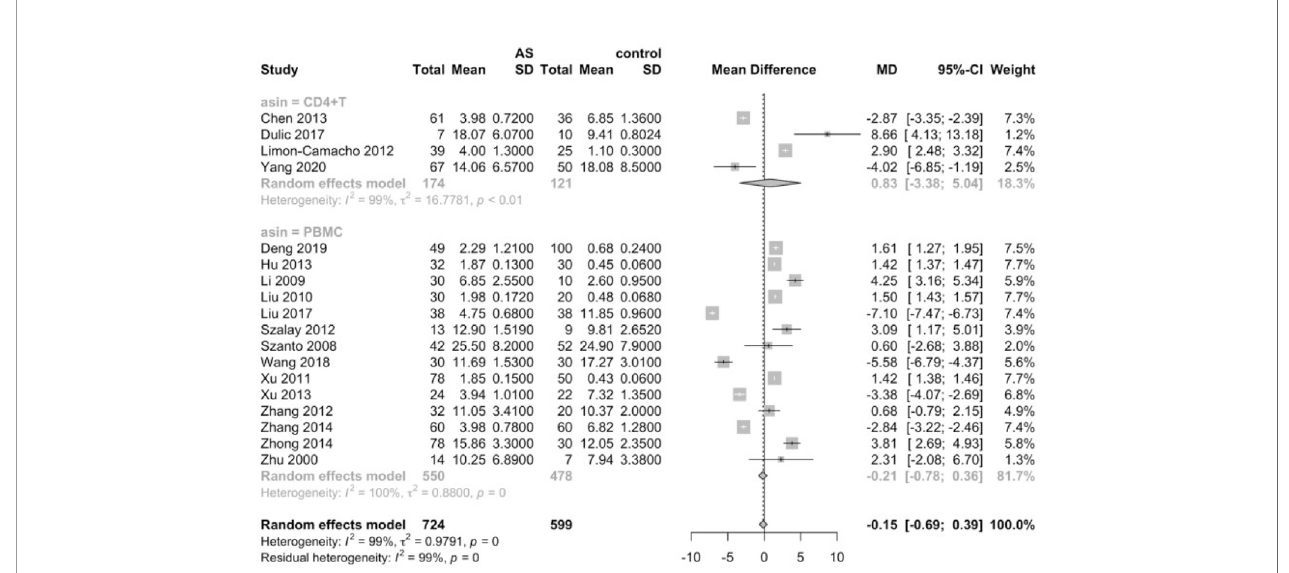
FIGURE 5 | Proportions of Th1 cells among PBMCs and CD4+ cells.